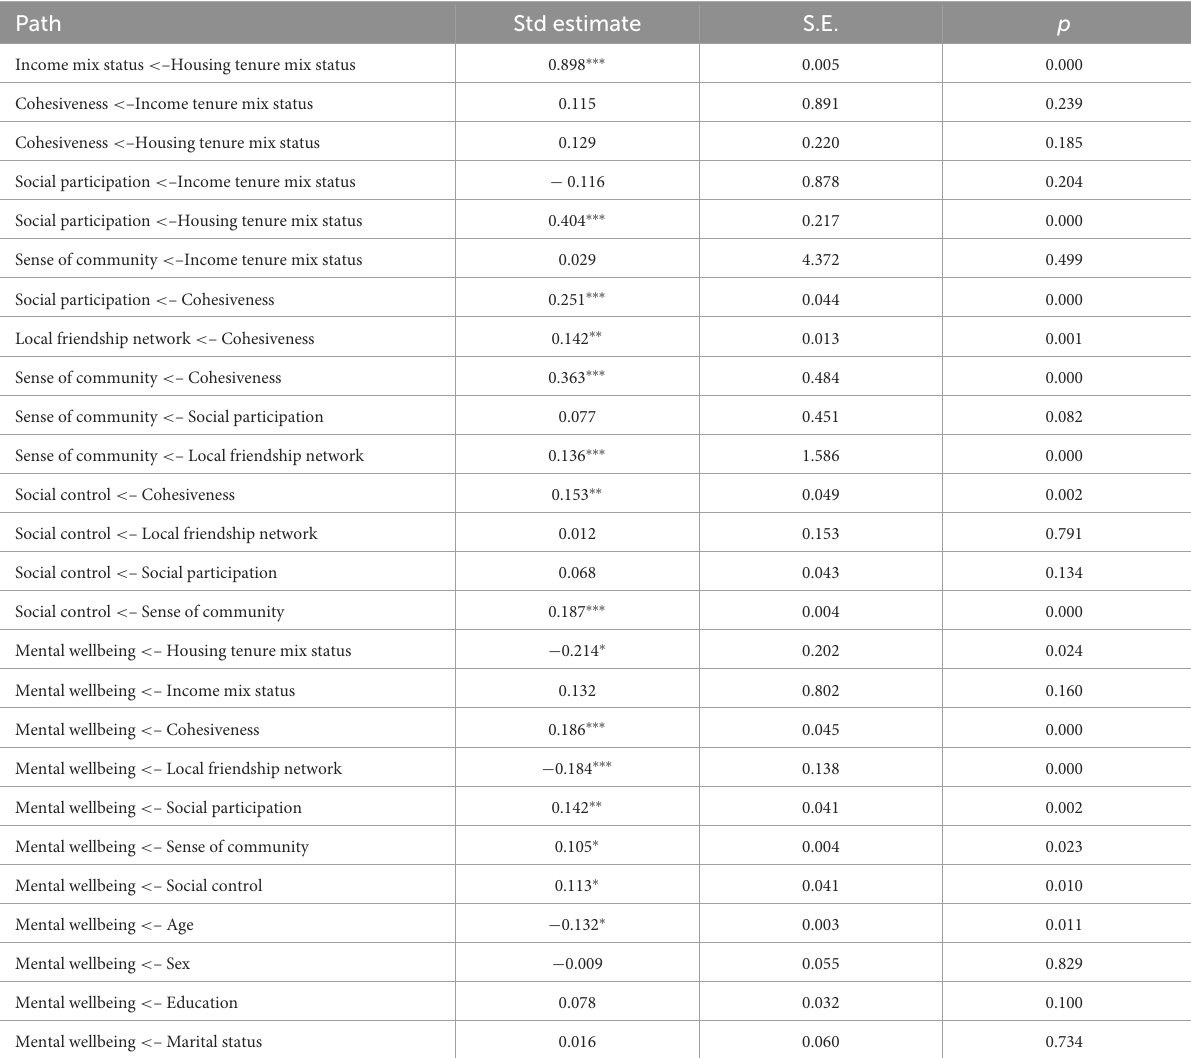
TABLE 2 Direct paths among variables of housing and social mix, social environment, and mental wellbeing (standardized estimates, N = 501).